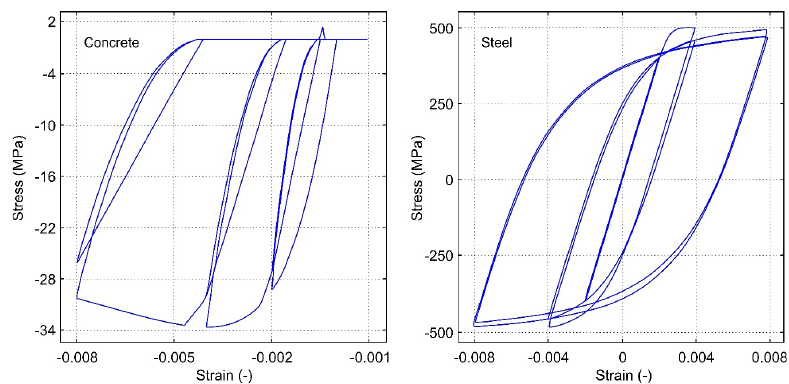
Figure 6. Material models for concrete and steel considered in the study [80].